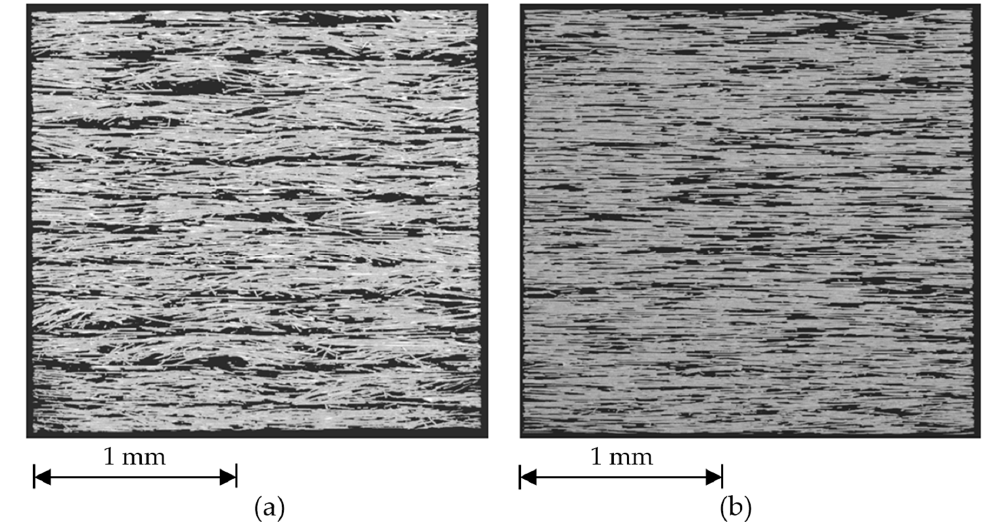
Figure 4. Three-dimensional visualization of longitudinal sections (depth of 150 µm) in the XZ plane of (90, 90) specimens printed with layer thicknesses of ( a ) 0.30 mm and ( b ) 0.10 mm.